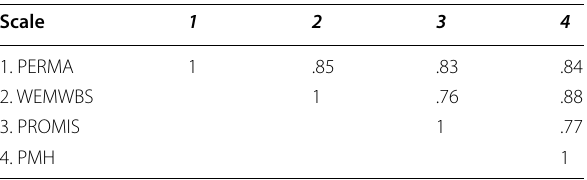
**Correlation is significant at the 0.01 level